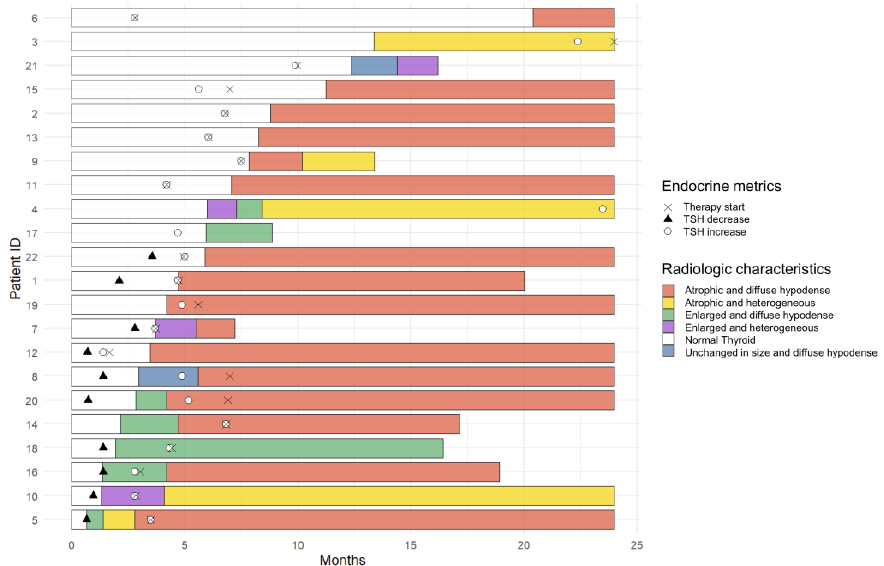
Figure 4. Temporal changes in the CT findings correlating with TSH level and the start of hormone replacement therapy in each patient among 22 patients who had both clinical and radiologic immune-related thyroiditis. Four patients showed imaging abnormality before TSH abnormality, and all demonstrated hypothyroidism. The rest of 18 patients demonstrated abnormal TSH levels at the same time or before the imaging abnormality (10 thyrotoxicosis, 8 hypothyroidism). Black triangle indicates the time point when the patient had thyrotoxicosis (TSH < 0.3 mIU/L) and white circle indicates the time point when the patient had hypothyroidism (serum TSH > 5.0 mIU/L). Cross indicates the date of starting thyroid hormone replacement therapy.